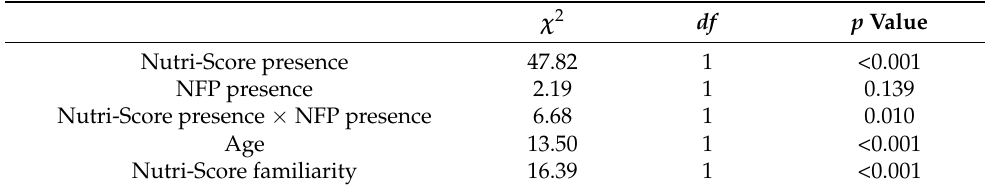
Table 4. The fixed part of the mixed-effects model explaining AM based on Nutri-Score and NFP, Age, and Nutri-Score familiarity.